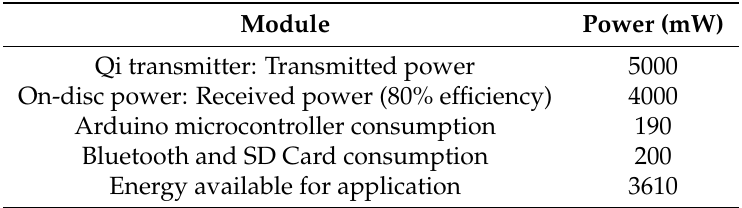
Table 3. Power management of an electronic disc for lab-on-a-disc